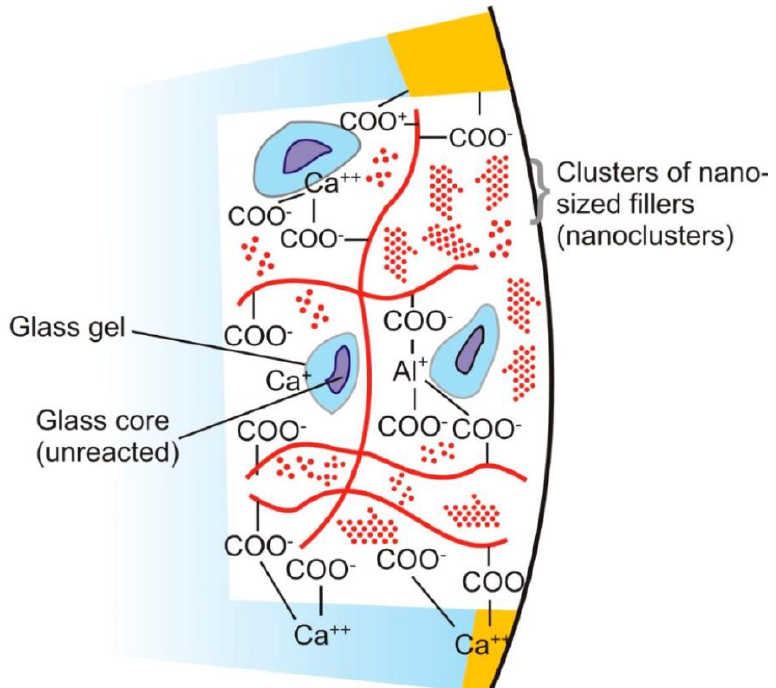
Figure 1. Diagram represents the structure of glass ionomer cement and its chemical bonding with tooth structure. Adopted from reference [24].